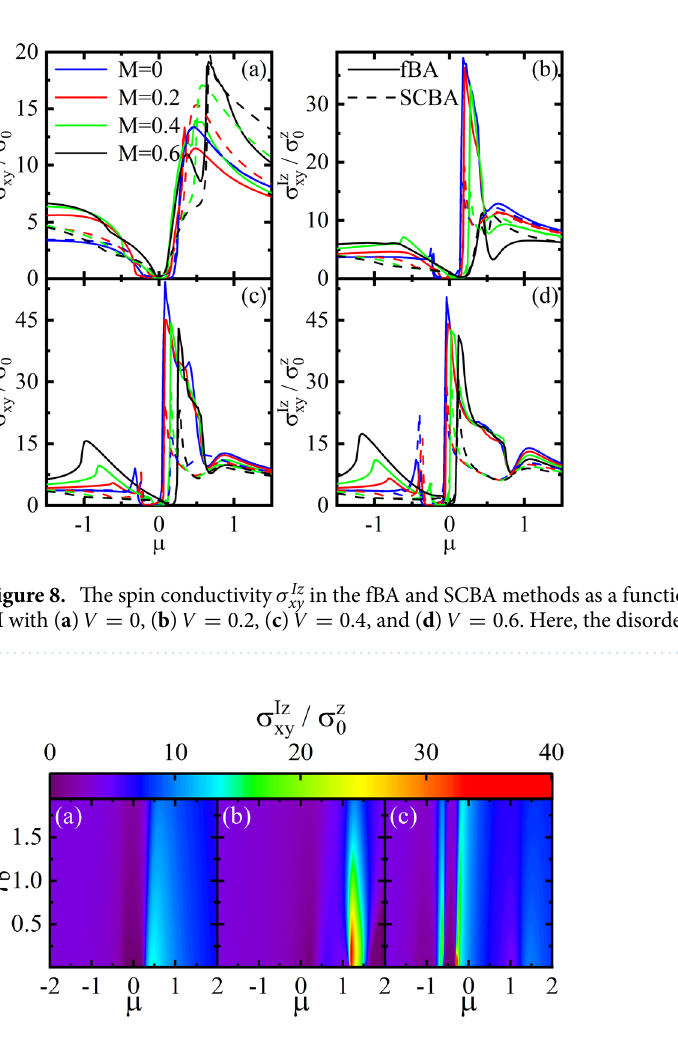
Figure 9. Density plot of the spin conductivity σ Iz xy in the SCBA method as functions of the disorder parameter γ b and µ for ( a ) M = 0 and V = 0 , ( b ) M > V with M = 1.5 and V = 0.2 , and ( c ) M < V with M = 0.2 and V = 1 . Here (cid:31) = 0.2 , s=1, and